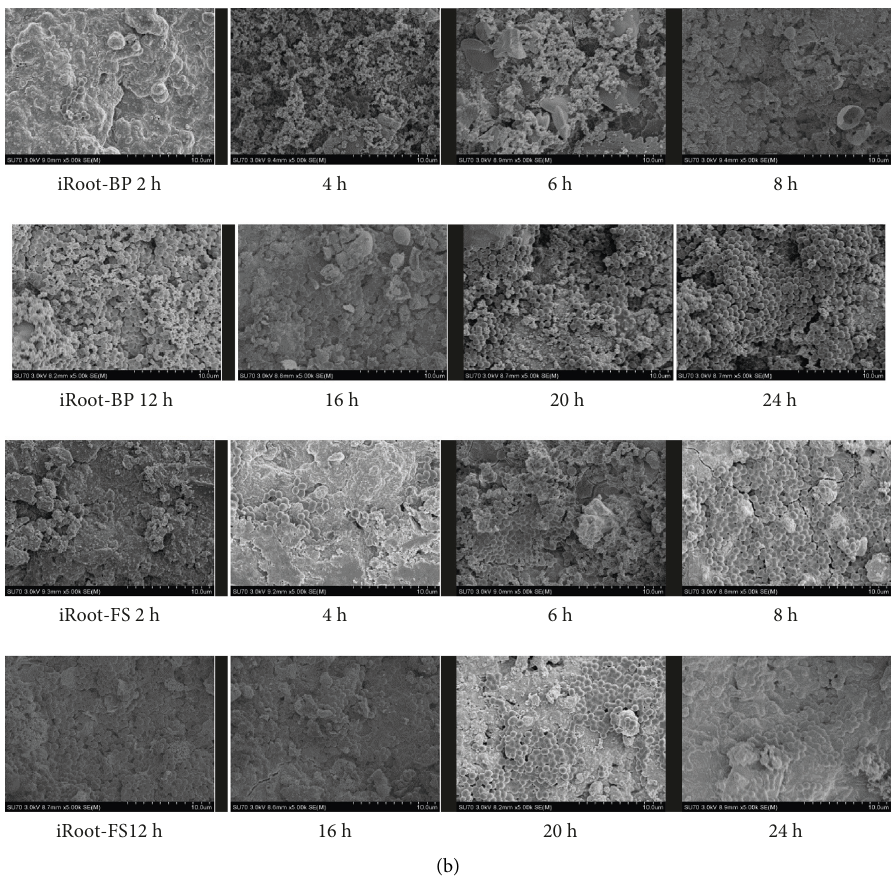
Figure 9: Electron microscopy pictures of the Porphyromonas gingivalis group.